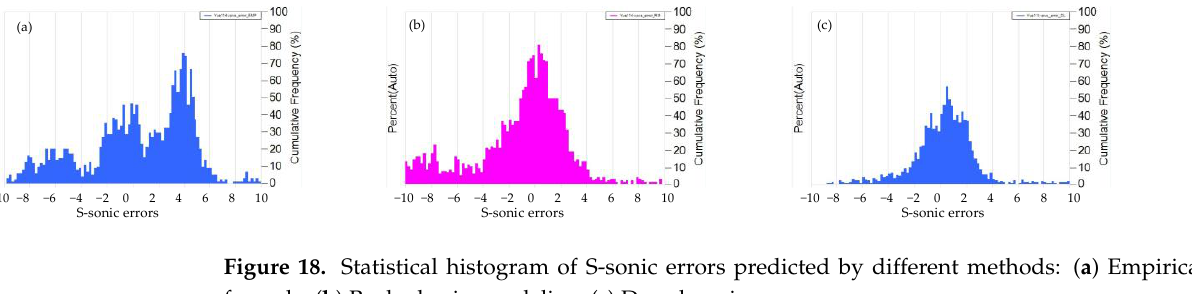
Figure 17. Comparison of S-sonic curves predicted by different methods (dts_emp, DTS_RM, KERAS_DTS were calculated, respectively, by the empirical formula, the rock physics modeling method, deep learning, and DTS is the measured S-sonic curve).